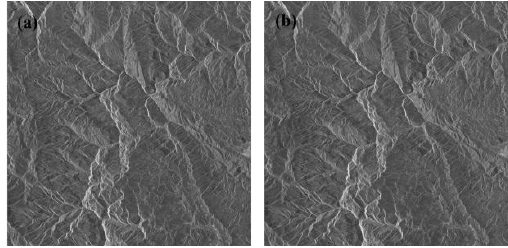
Figure 2 The intensity diagram of the main image (a) and the secondary image (b) (after